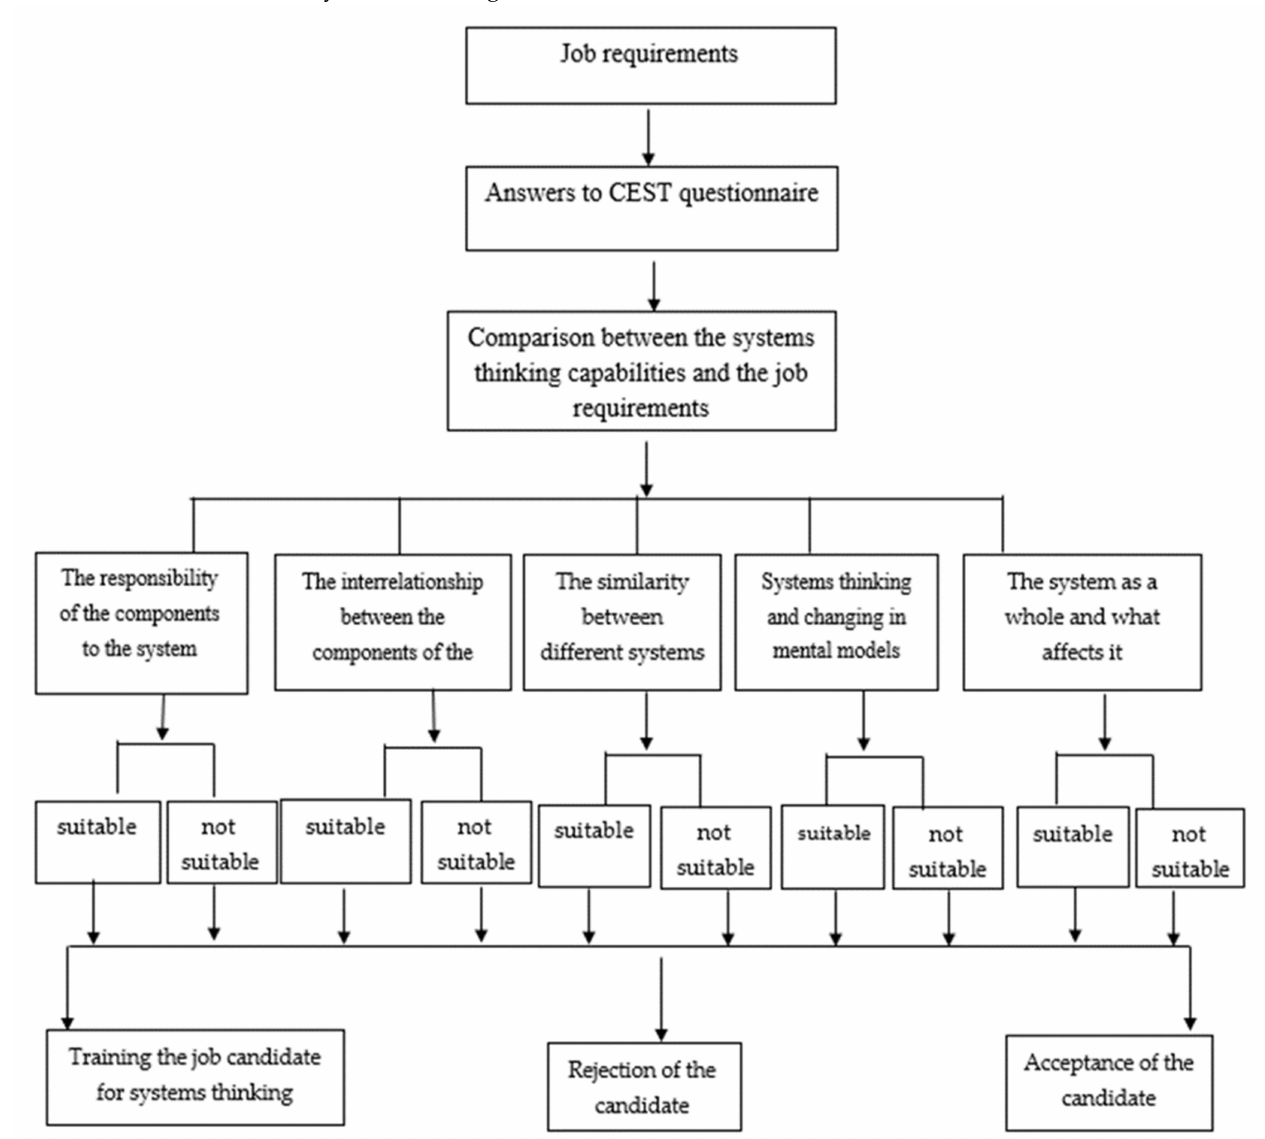
Figure 1. A system model for adapting systems thinking capabilities of a job candidate to the job